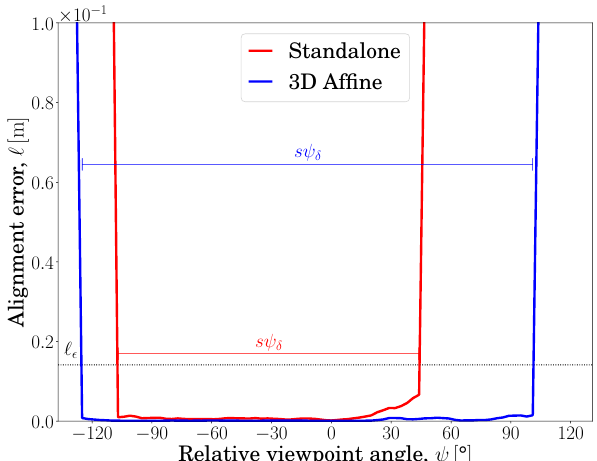
Figure 9. The proposed embedding, denoted by the blue curve, is compared with the standalone feature approach, represented by the red curve. The proposed embedding remained viewpoint (cid:96) (cid:101) ) over a large interval of ψ -axis values. Thus, it outperformed the standalone invariant (i.e., (cid:96) ( ψ ) ≤ intensity-based approach. The dotted horizontal line denotes the maximally tolerated alignment error, (cid:96) (cid:101) ; the longer a curve, (cid:96) ( ψ ) , remains below this line, the larger its invariance score, ψ δ , where s is a normalizing constant. In this setting, the SURF [20] detector and the SIFT [19] descriptor were evaluated on a synthetic dataset resembling the ‘C. T. Crunch’ object observed from the NP1 camera.